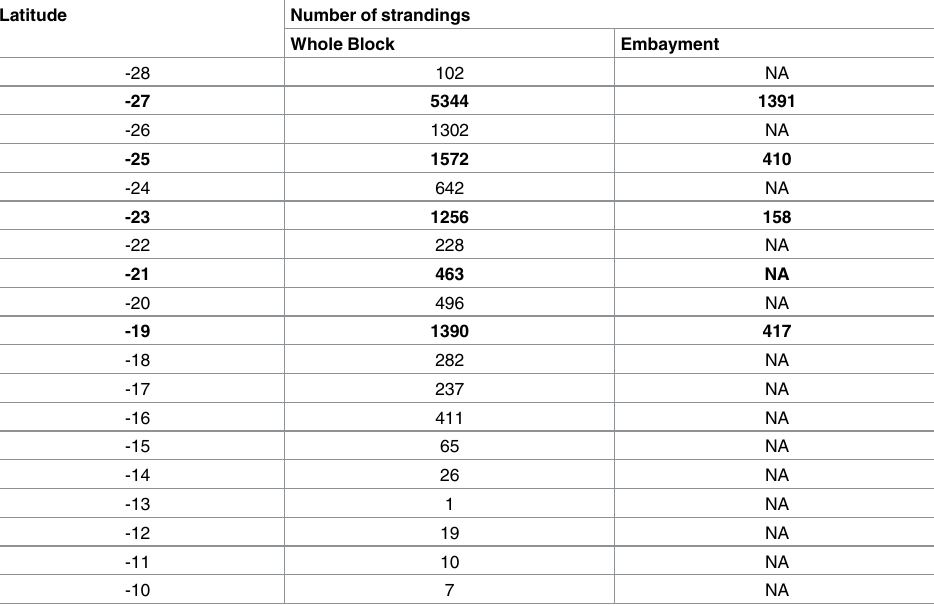
Table 1. Number of marine turtles reported stranded in each latitudinal block. NA represents not ana- lyzed. Boldedlatitudesare the recognised hotspots. Latitude